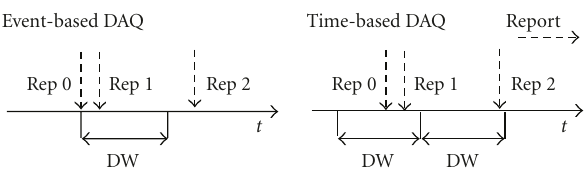
Figure 25: The DAQ logic: the event-based opens the DW at the arrival of a report from Node 0; the time-based opens the DW regularly as a function of the